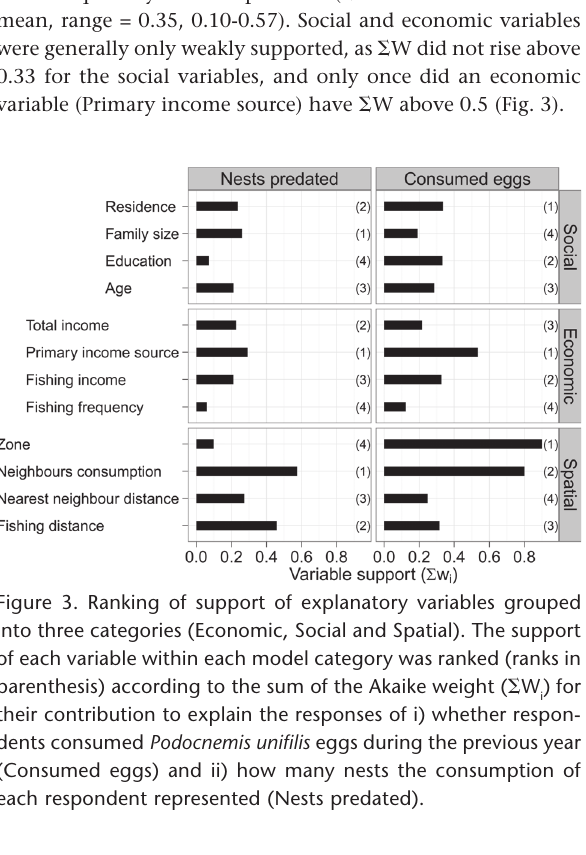
Table III. Clutch size of Podocnemis unifilis obtained from the literature. River/basin